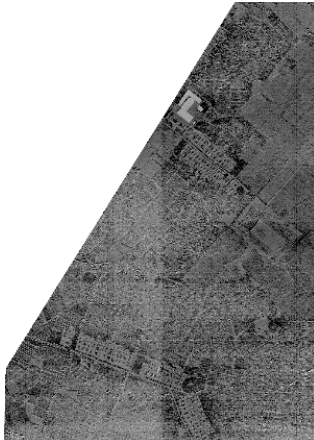
Figure 7. The normalized difference vegetation index (NDVI) map of the observed area.